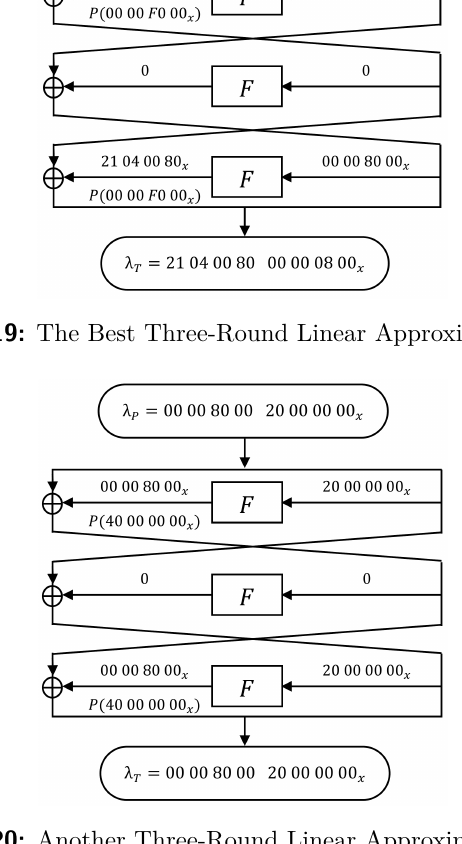
Figure 20: Another Three-Round Linear Approximation ( λ 10